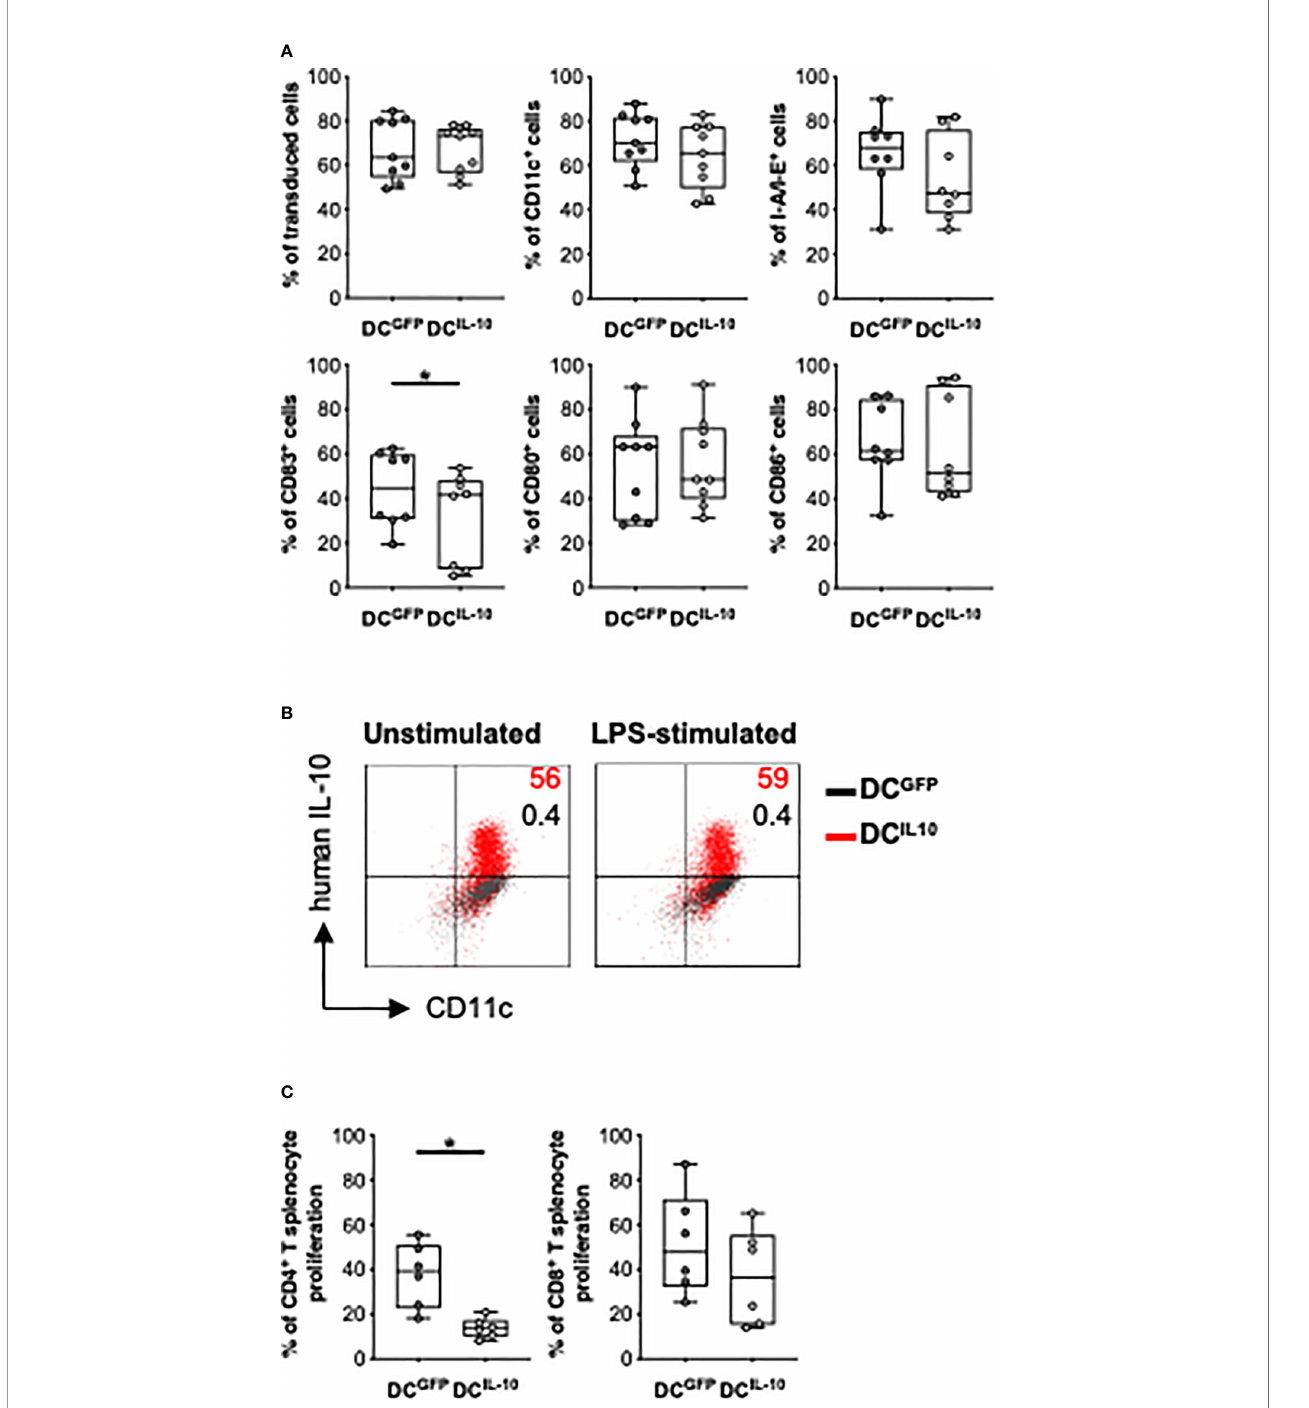
FIGURE 8 | In vitro characterization of murine DC IL-10 . Female Balb/c BM cells were differentiated into DC, transduced at day 2 with LV-GFP (DC GFP ) or LV-IL-10 (DC IL-10 ), and activated with LPS (200 ng/ml) during the last 2 days of differentiation. (A) Transduction ef fi ciency was quanti fi ed based on Δ NGFR expression and the expression of the indicated markers was analyzed at day 9 of differentiation by fl ow cytometry. Each dot represents a single experiment (n = 8-9), lines indicate median, while whiskers are minimum and maximum levels. (B) DC were plated and left unstimulated or stimulated with LPS (200 ng/ml) for 24 h, with the addition of brefeldin A at 6 h. The expression of human IL-10 was quanti fi ed by intracytoplasmic staining. One representative donor out of two is depicted, and percentages of positive cells are indicated. (C) Spleen cells from female C57Bl/6 mice were stained with a proliferation dye and stimulated with Balb/c DC GFP and DC IL-10 at 1:10 ratio. At day 5, proliferation of CD4 + and CD8 + T cells was measured by fl ow cytometry. Each dot represents a single donor (n = 6), lines indicate median, while whiskers are minimum and maximum levels. *P ≤ 0.05 (Wilcoxon matched pairs test,